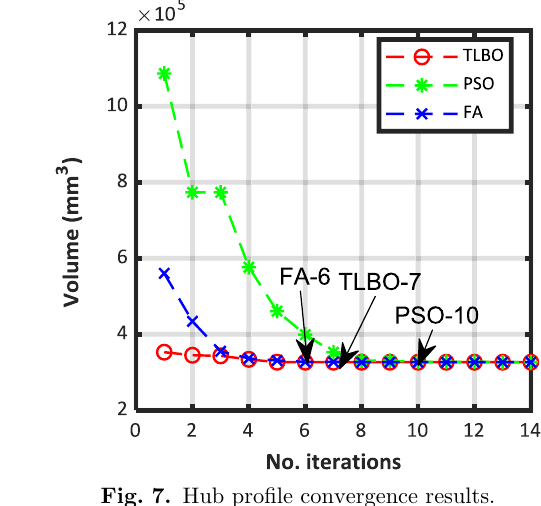
Fig. 7. Hub pro fi le